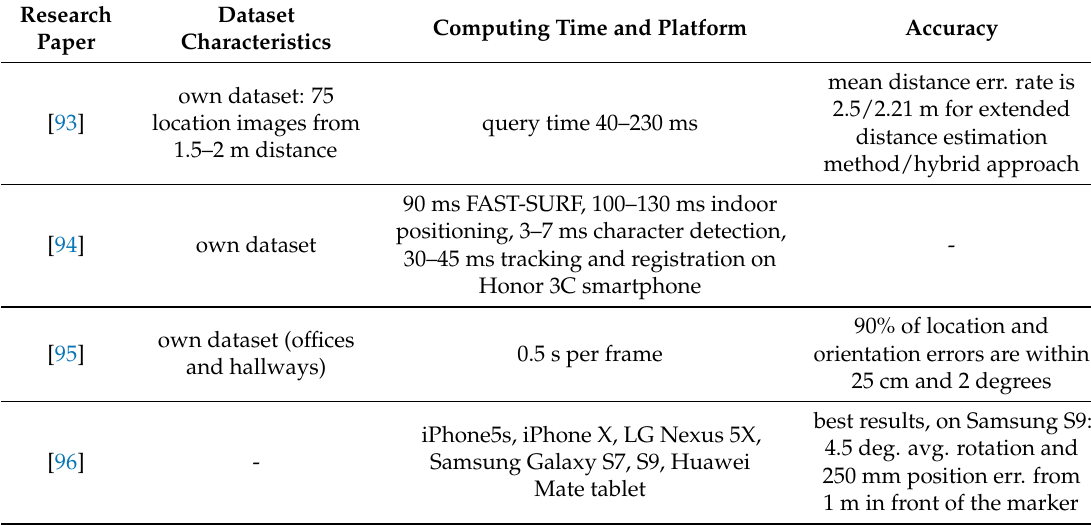
Table 11. Characteristics of indoor localization solutions with real image/feature databases, 2D cameras + other sensors, and traditional image